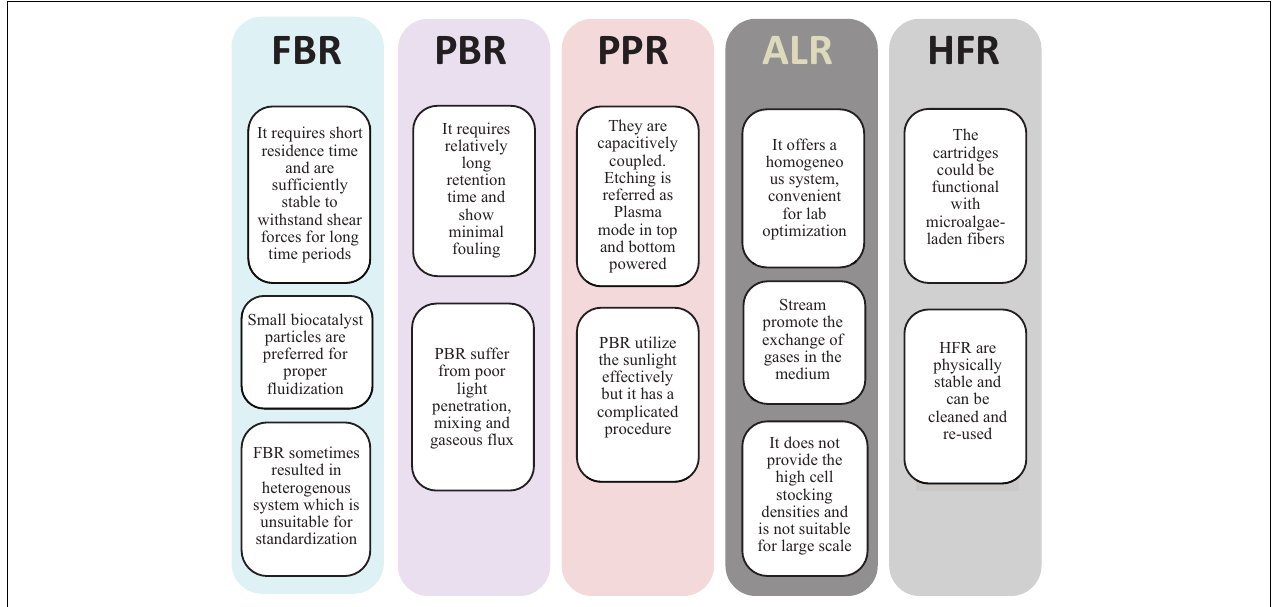
FIGURE 1 | Characterization of different types of immobilized